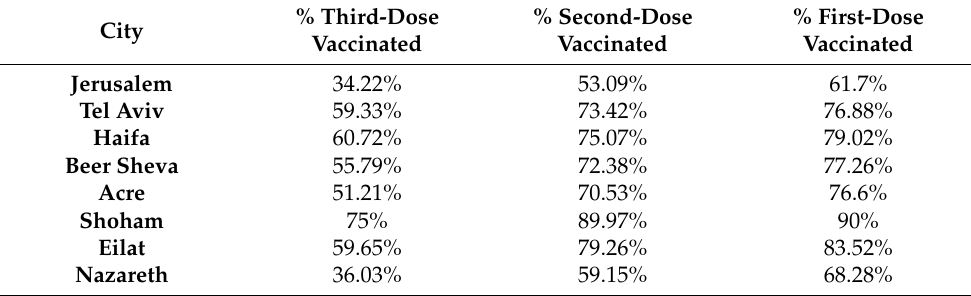
Table 4. Immunization by city in Israel (up to 13 June 2022).